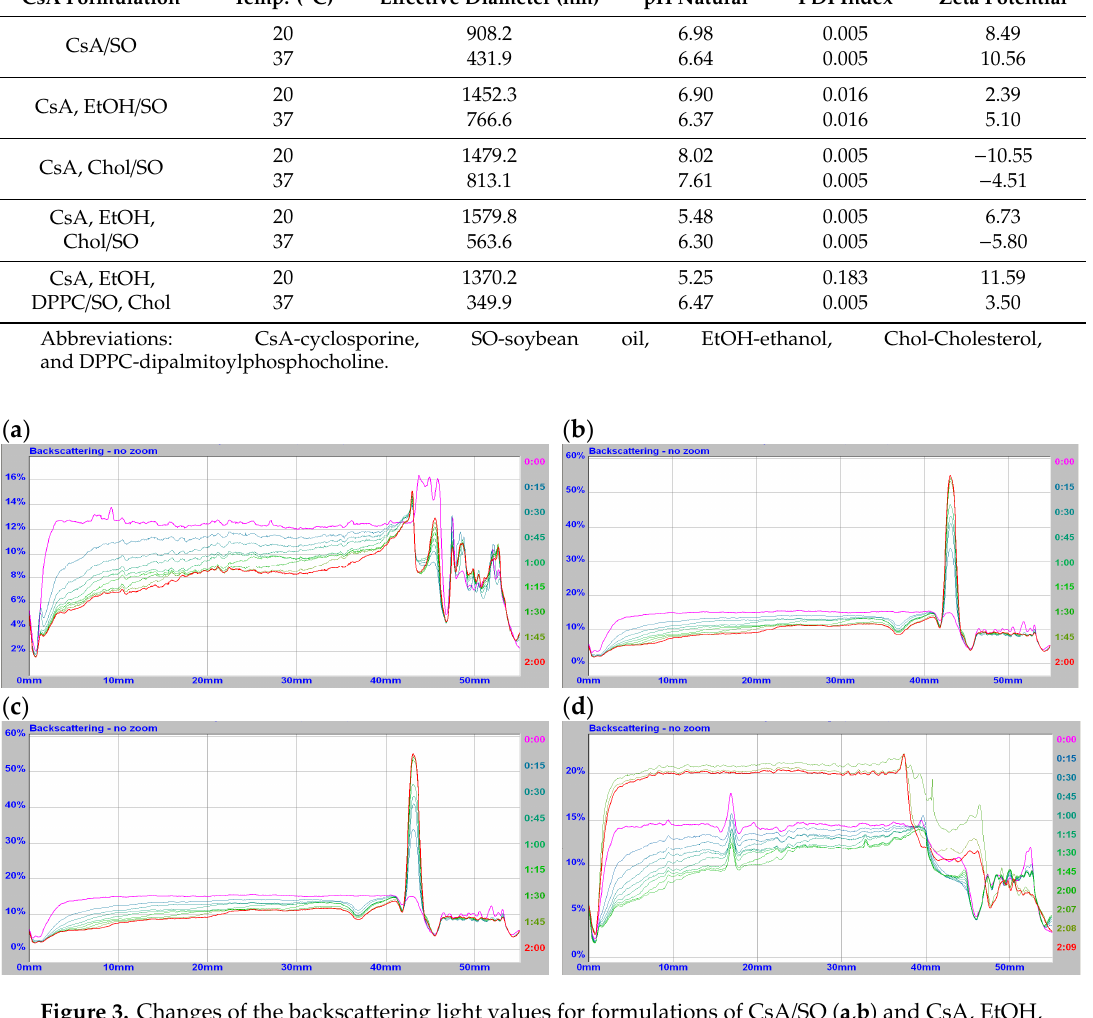
Table 3. Formulation characterization of CsA / soybean oil, and cholesterol (o / w emulsion). CsA Formulation